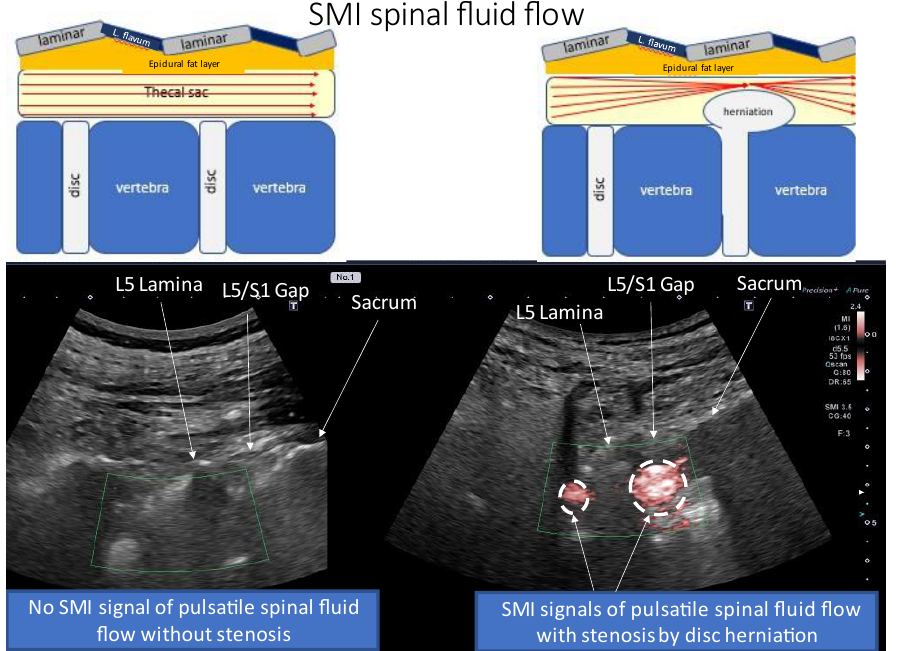
Figure 7. Paramedian sagittal oblique sonogram of the lumbar spine. A pulsatile SMI signal associated with the cerebrospinal fluid flow was detected in lumbar disc herniation. The ( left ) image shows no SMI signal at the L4/5 and L5/S1 interlaminar spaces without stenosis. The ( right ) image